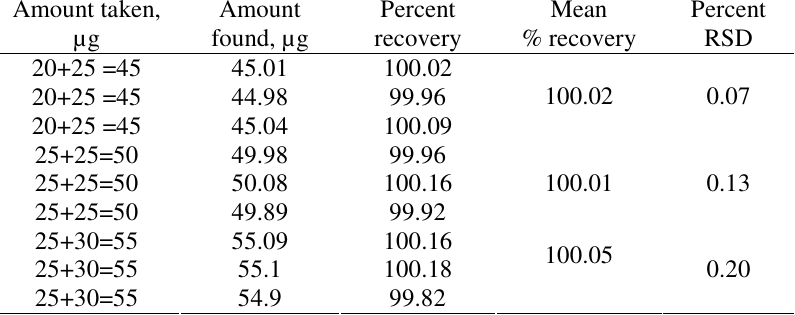
Table 3. Accuracy data (Triplicate values at 80, 100 and 120 percent